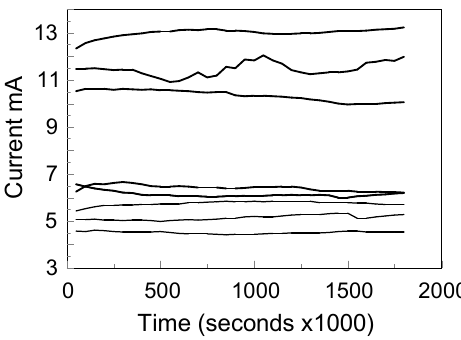
Figure 25. Potentiostatic polarization curves before the fracture of the pin, in the case of the link/driven pin assembly. Sample #7.